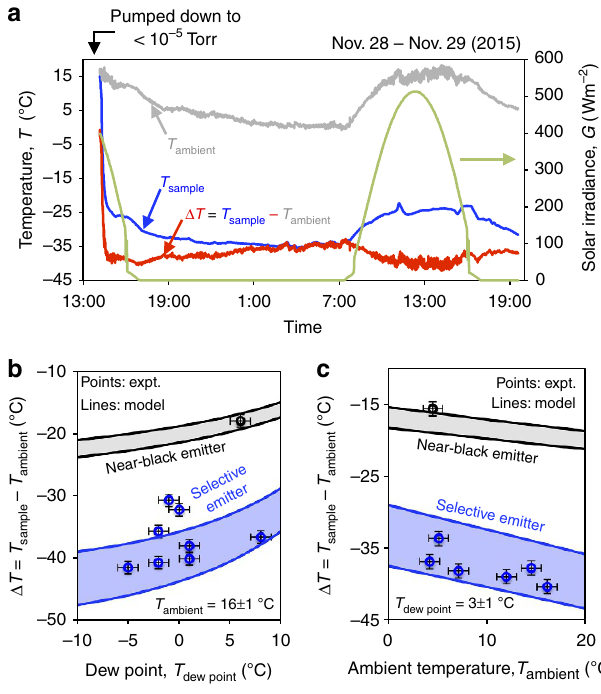
Figure 4 | Experimental results. ( a ) Large temperature reduction below ambient through radiative cooling in a 24-h day–night cycle. After pumping down to 10 (cid:2) 5 Torr, the selective emitter rapidly cools down to B 40 (cid:2) C below ambient temperature within half hour. A maximal cooling of 42.2 (cid:2) C synchronizes with the peak of the solar irradiance, confirming the function of the sun-shade and the mirror-cone (Fig. 2), and also highlighting the high contrast between the ambient temperature and the dew point during this period. ( b ) Comparison with theoretical models: temperature reduction, D T , as a function of dew point, with the ambient temperature fixed at T ambient ¼ 16 ± 1 (cid:2) C. ( c ) D T as a function of ambient temperature, with the dew point fixed at T dew-point ¼ 3 ± 1 (cid:2) C. Shaded areas, grey for near-black emitter and blue for selective emitter, represent the uncertainties of the model resulting from the uncertainties in estimating the parasitic heat losses and the absorption of the diffuse solar irradiance (for details, see Supplementary Notes 1 and 5). The error bar represents a conservative estimate on the sensitivity of our K-type thermocouples and the uncertainty in interpolating the dew point from a weather station at Stanford. Results in ( b , c ) underline a guideline to achieve large temperature reduction through radiative cooling: selective emitter with low dew point and high ambient